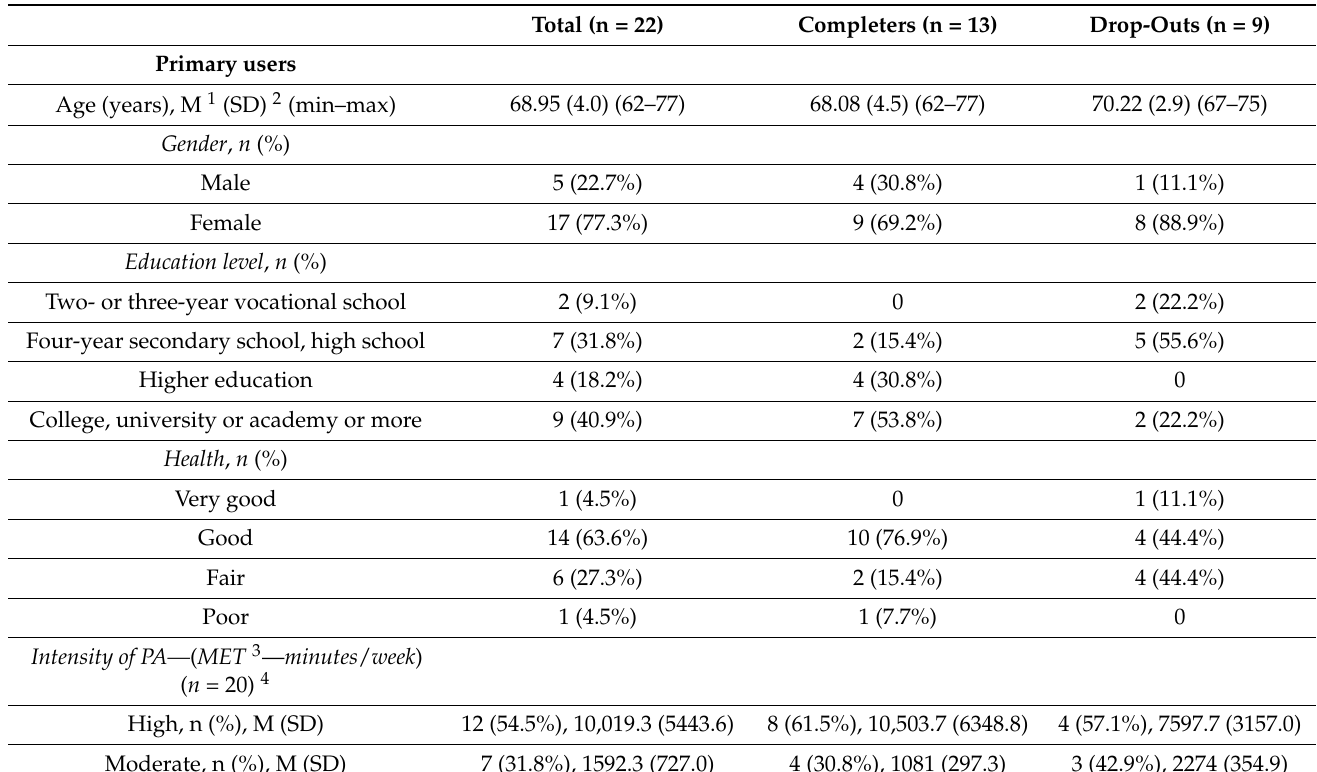
Table 1. Baseline characteristics of all participants, participants who completed the study, and participants who dropped